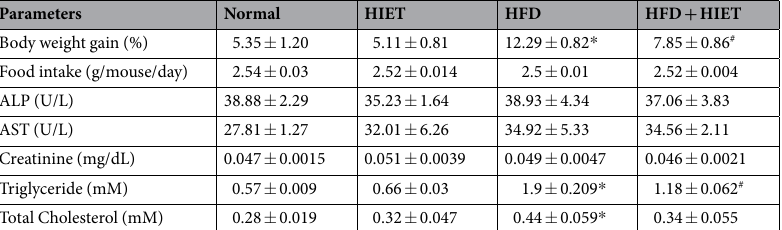
Table 1. Body weight gain, food intake, liver (ALP and AST) and kidney (creatinine) function test, triglyceride (TG), and total cholesterol (TC) levels in the experimental animals. Both normal and HFD-fed mice were gavaged with either olive oil or HIET (20 µ g/kg BW, daily for 8 wks) respectively. Values are mean ± SE. “ * ” Denotes the significant difference from Normal ( * p < 0.05) and “#” denotes the significant difference from HFD mice ( # p <